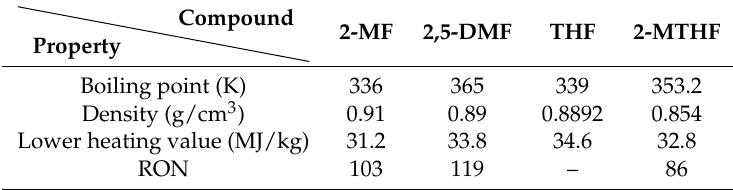
Figure 2. Chemical structures of starting platforms and resulting fuels for furan and substituted furans. HMF, 5-hydroxymethyl-2-furaldehyde; 2-BF, 2-butylfuran; 2-MF, 2-methylfuran; 2-FFOH, 2-furfuryl alcohol; 2,5-DMF, 2,5-dimethylfuran. Table 1. Thermophysical properties of the most promising furan-based biofuels [31,34,35]. 2-MTHF, 2-methyltetrahydrofuran; RON, research octane